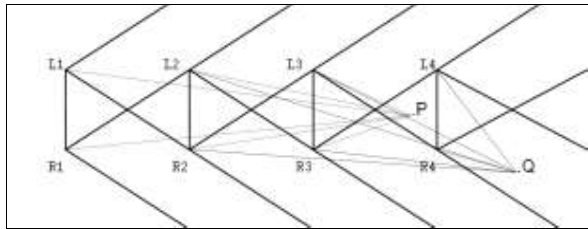
Figure 1 – Photogrammetric bridging or traverse – conceptual illustration (Silva,